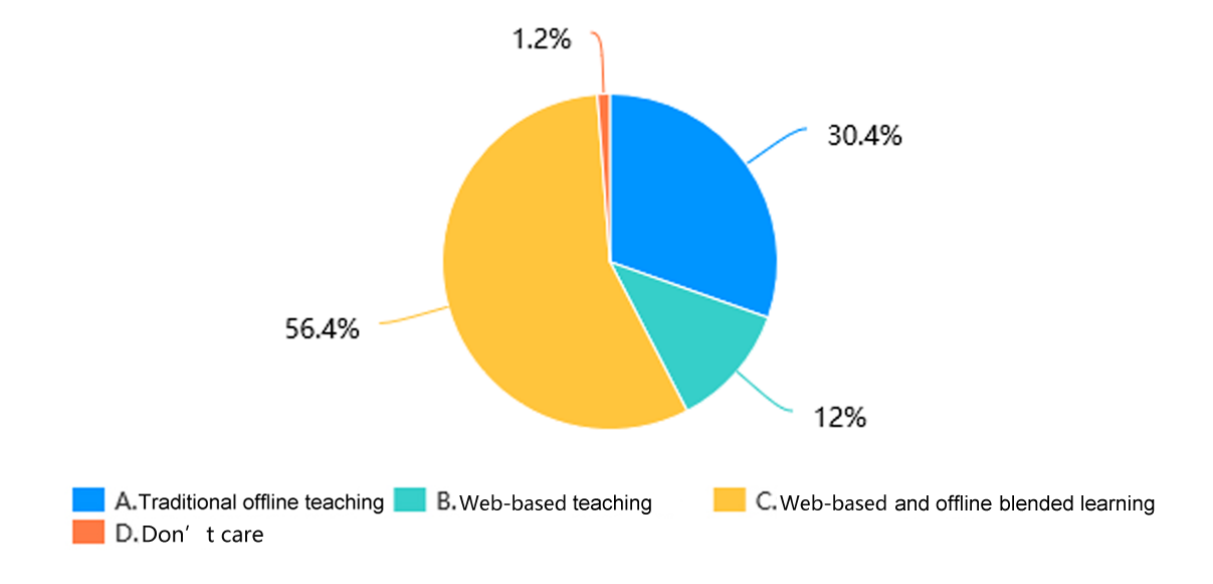
Figure 10. The proportions of students who would choose different teaching methods of pathology in the future in the control